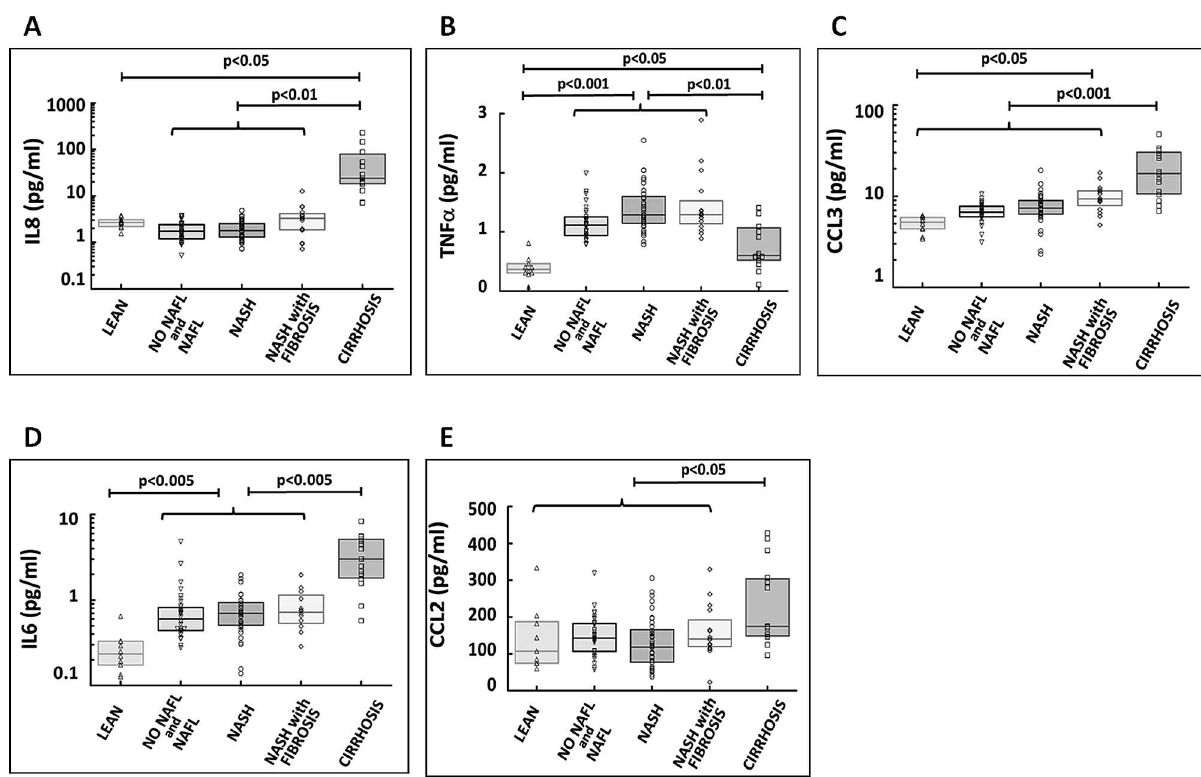
Fig 4. Plasmacytokine and chemokine levels across histological subgroups. Plasma IL8, TNF α and CCL3were significantly different betweenhistological subgroups (Fig 4A-4C). Plasma IL6 and CCL2were significantly higherin patients with cirrhosis comparedto other patient groups (Fig 4D and 4E) (see also Fig